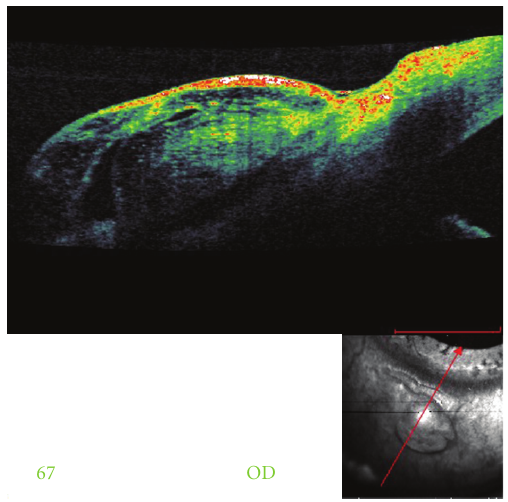
Figure 1: A noncontrast CT scan demonstrating foreign body resting on the zonules area.